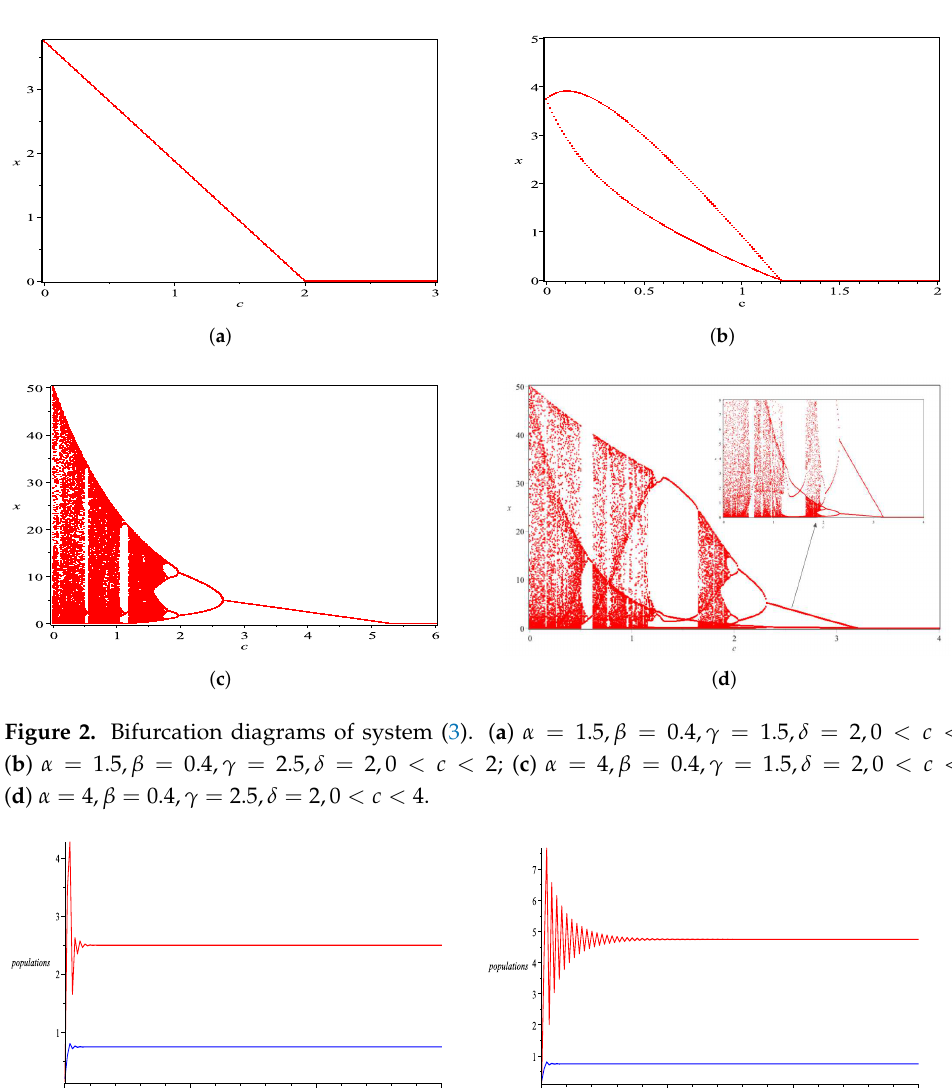
Figure 3. The stability of interior fixed point of systems (3) and (4), respectively. ( a ) k = 0; ( b ) k = 0.3. Example 2. Next, taking k = 0.5 with initial value ( x 0 , y 0 ) = ( 0.15, 0.2 ) and other